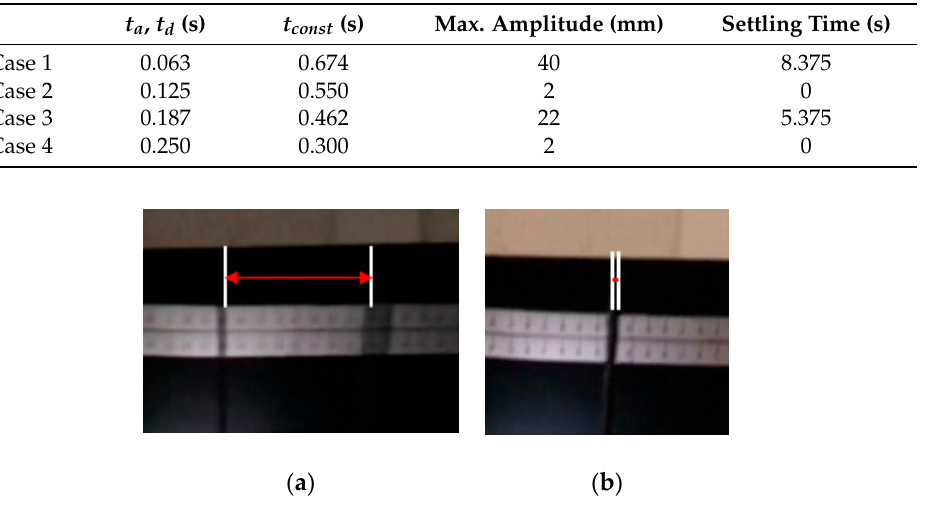
Figure 13. Position deviations at target: ( a ) when 𝑡 (cid:3028) = 0.063 ; ( b ) when 𝑡 (cid:3028) = 0.250 .